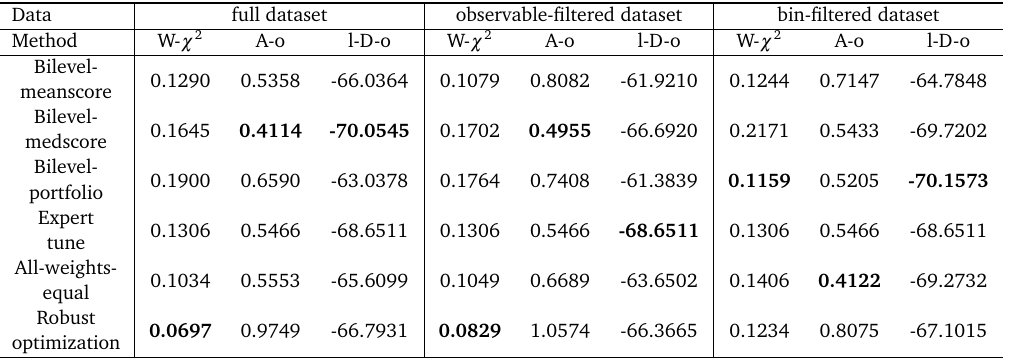
Figure 16: Cumulative distribution of bins in each category of the A14 dataset at different bands of variance levels computed with the rational approximation (RA) ( p ) = ( f b ( p ) − R b ) 2 given by, r b ∆ f Table 21: A14 results with the full dataset , observable-filtered dataset and bin- filtered dataset when using the cubic polynomial approximation, calculated on the full dataset. Lower numbers are better. The best results are in bold. In each dataset, W- χ 2 refers to the Weighted χ 2 metric, A-o refers to the A-opt metric, and l-D-o refers to the log D-opt